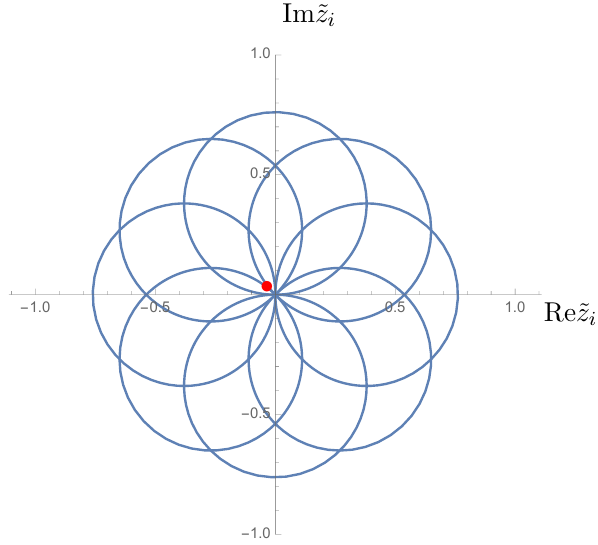
Figure 1 . Parametric plot of ˜ z i ( µ ) in (2.11) for the Janus solutions with α i = 1 and β i = nπ n = 0 , . . . , 7 . The central red point at ˜ z i = 0 ∀ i corresponds to the maximally supersymmetric AdS 4 vacuum and describes the asymptotic values at µ → ±∞